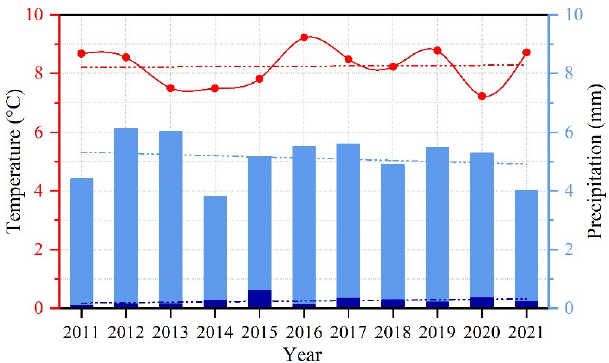
Figure 9. Variations in the average air temperature and the precipitation from June to September. The red dots represent the air temperature, the light blue bars represent the total amount of precipitation, the dark blue bars represent the amount of solid precipitation, and the dotted line represents the linear trend.